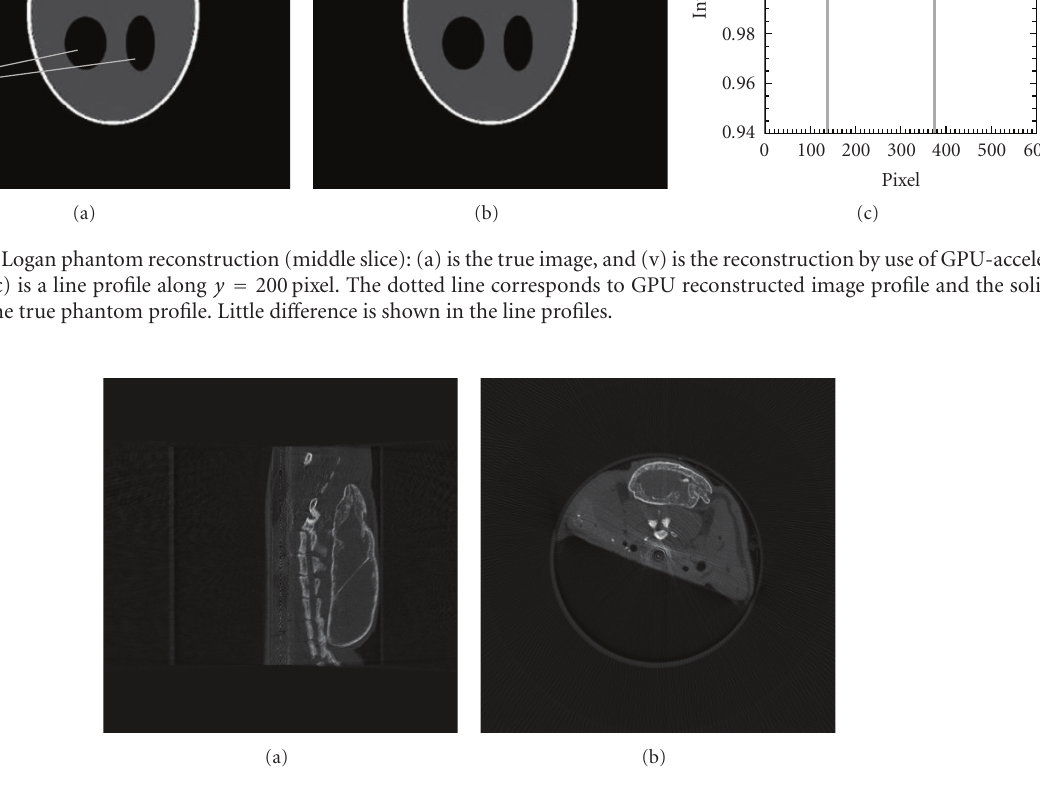
Figure 8: A mouse reconstructed by use of GPU-accelerated FDK program from the micro-CT data: (a) the sagittal slice of the mouse, (b) the middle transverse slice of the